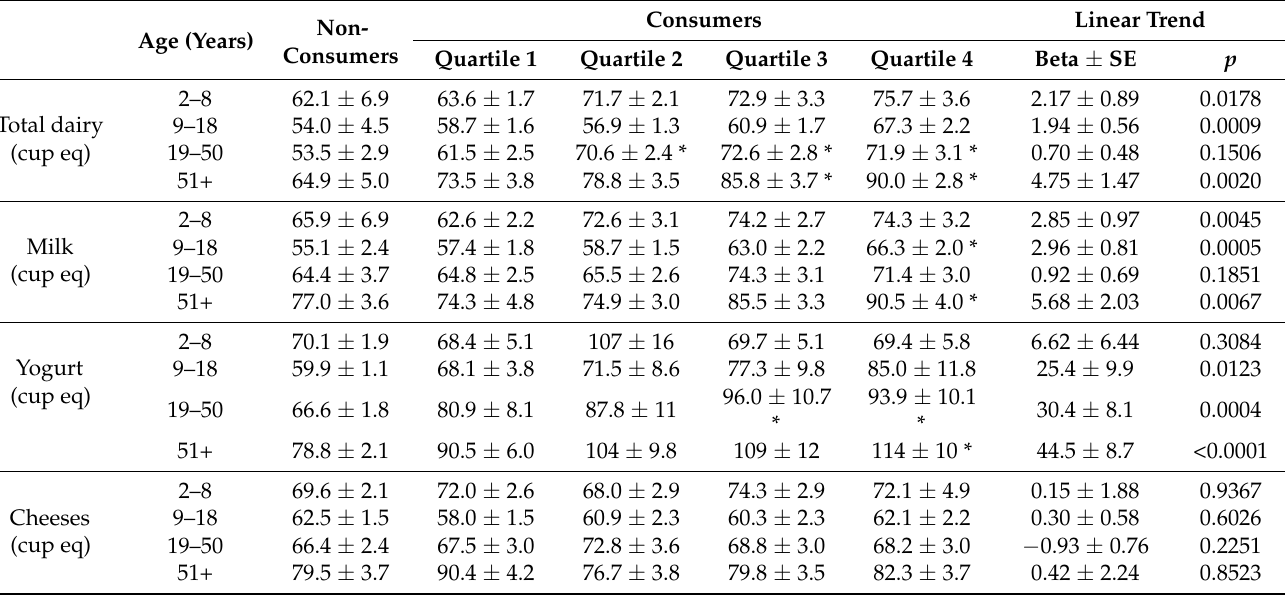
Table 4. Serum pyridoxal 5 (cid:48) - phosphate (Vitamin B 6 ) status (nmol/L) by dairy intake in different age groups.